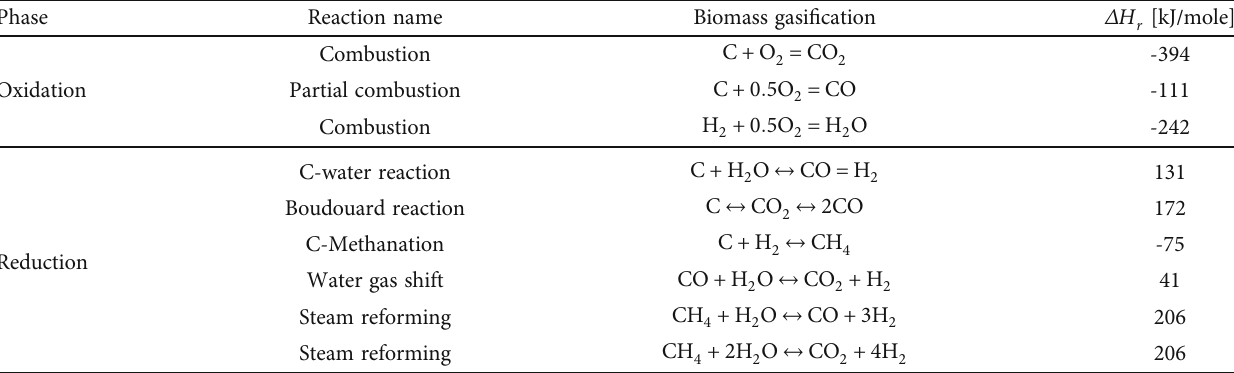
Table 2: Biomass gasi fi cation chemical reactions.